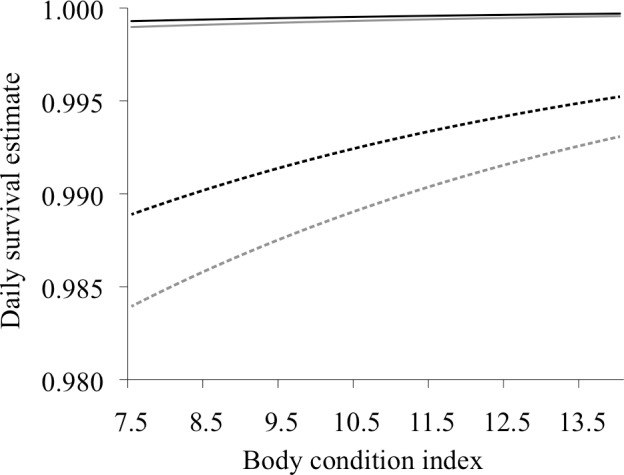
Relationship between estimated daily survival rate and body condition index for snowshoe hares.Estimates are shown for hares collared in the Conifer (black lines) and Deciduous (grey lines) trapping grids in July (solid lines) and November (dashed lines) (the months of highest and lowest snowshoe hare survival) in Bonanza Creek Experimental Forest near Fairbanks, Alaska, from June 2008 to May 2012. Estimates are based on the model S (Body Condition + Site + Month). Confidence intervals (95%, not shown) indicated some overlap between trapping grids within a season.